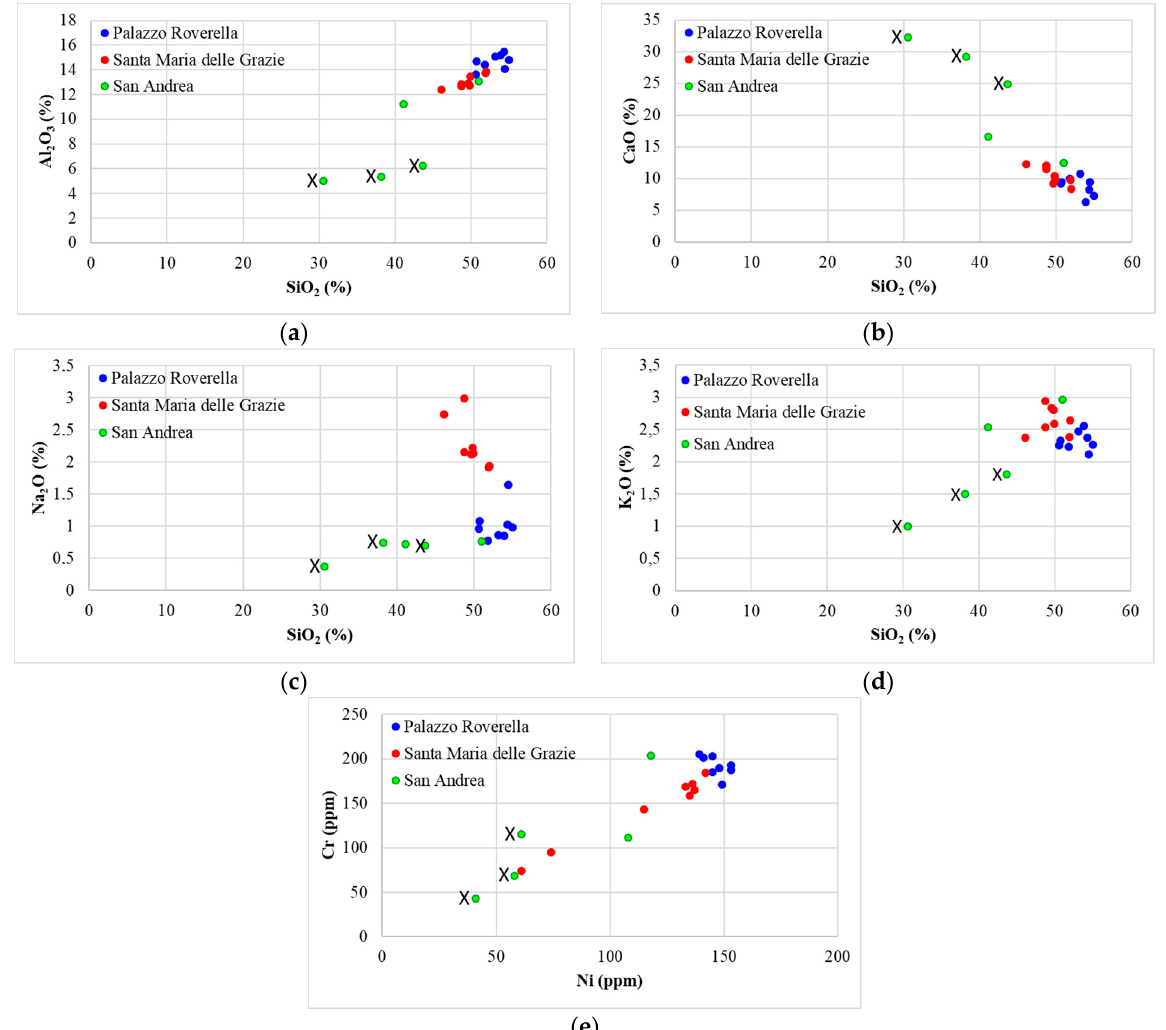
Figure 4. Binary diagrams on the XRF data of the samples collected in the three different sampling sites (blue = Palazzo Roverella; red = cloister of Santa Maria delle Grazie; green = bricks of the church of San Andrea; green and X = plaster of the church of San Andrea): ( a ) Al 2 O 3 -SiO 2 ; ( b ) CaO-SiO 2 ; ( c ) Na 2 O-SiO 2 ; ( d ) K 2 O-SiO 2 ; ( e ) Ni-Cr.